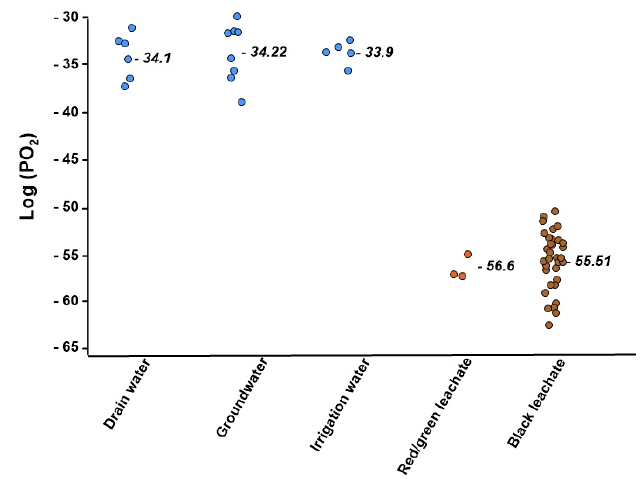
Figure 5. Bulk and mean value of calculated oxygen-equilibrating partial pressure for irrigation-, drainage-, ground-water and leachates.